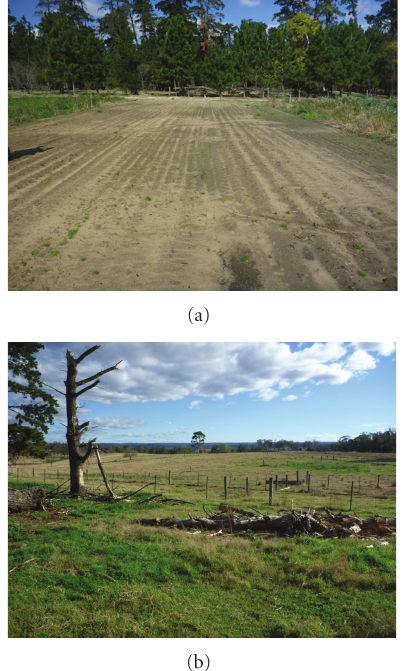
Figure 2: Experimental sites at PBI (a) and JBP